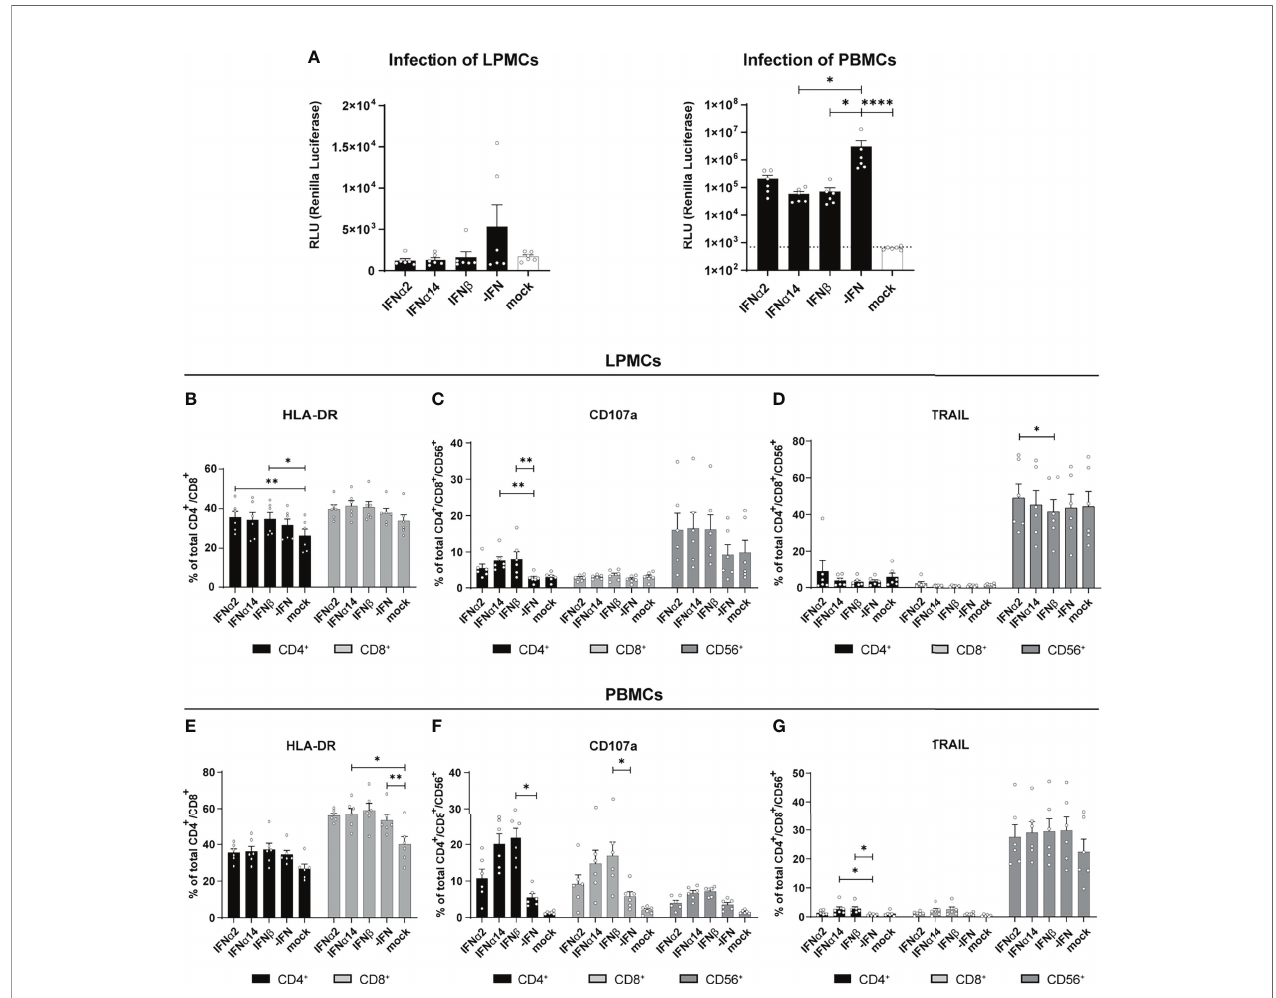
FIGURE 1 | Immune cell activation and cytokine expression after IFN treatment of in vitro infected LPMCs and PBMCs with HIV. LPMCs and PBMCs from healthy individuals were exposed to X4-HIV-1 NL4-3-IRES-Ren or mock treated with medium and subsequently treated with 2000 U/ml IFN a 2, IFN a 14, or IFN b . Cells were lysed 4 dpi and viral loads were determined by the relative light units (RLUs). (A) Inhibition of HIV replication by different IFNs in vitro. Additionally, fl ow cytometric analysis was performed to analyze immune responses by IFN a 2, IFN a 14, and IFN b . (B – D) Frequencies of HLA-DR + , CD107a + , and TRAIL + T and/or NK cells in LPMCs. (E – G) Frequencies of HLA-DR + , CD107a + , and TRAIL + T and/or NK cells in PBMCs. Mean values ± SEM are shown for n=6. Statistical analyses between the treated groups within a cell population were done by using Friedman test and Dunn ’ s multiple comparison test. ****, P < 0.0001; **, P < 0.01; *, P <